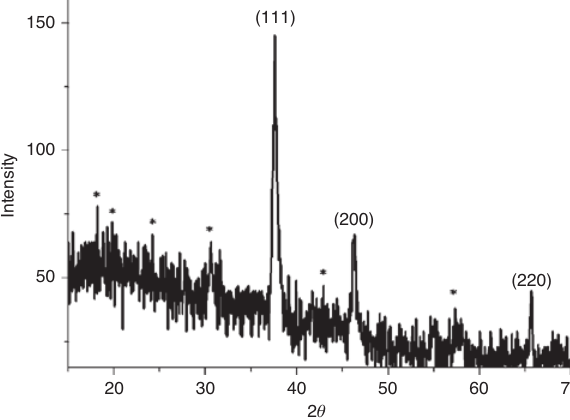
Figure 5: Powder XRD pattern of AgNPs. *Indicates unassigned peaks.